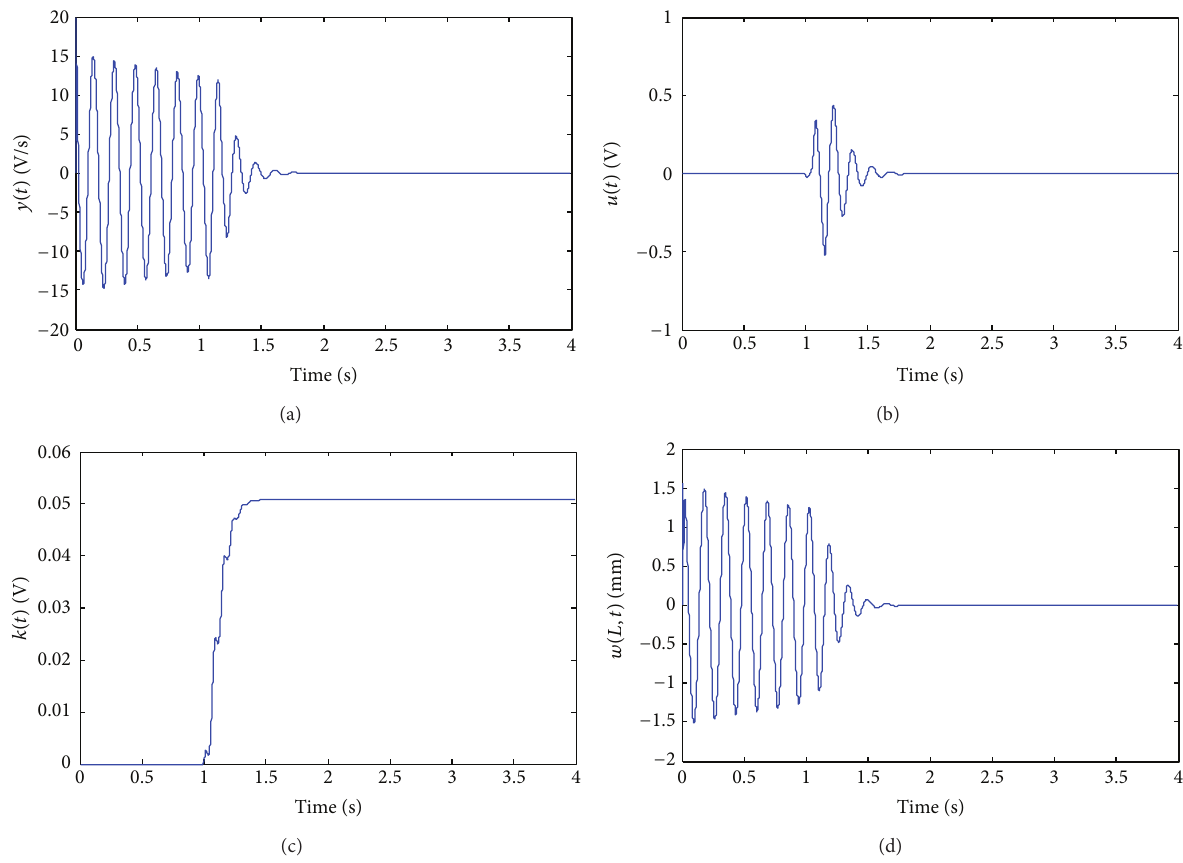
Figure 7: FEM simulation result (the controller was activated at 𝑡 = 1 sec): (a) feedback signal, (b) control signal, (c) adaptive variable, and (d) tip